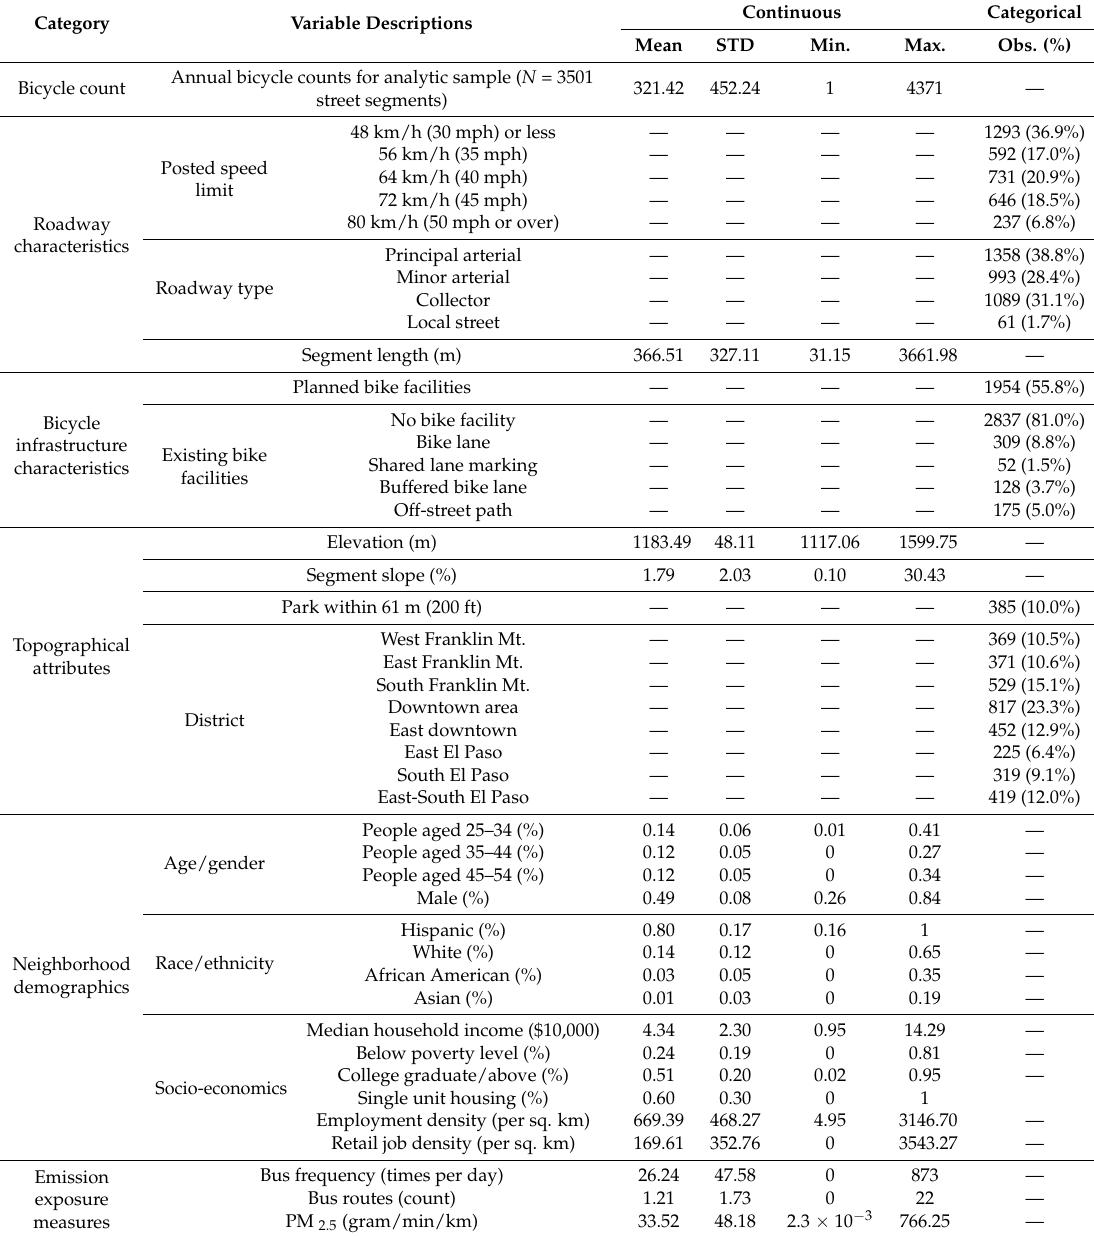
Table 3. Descriptive statistics of key